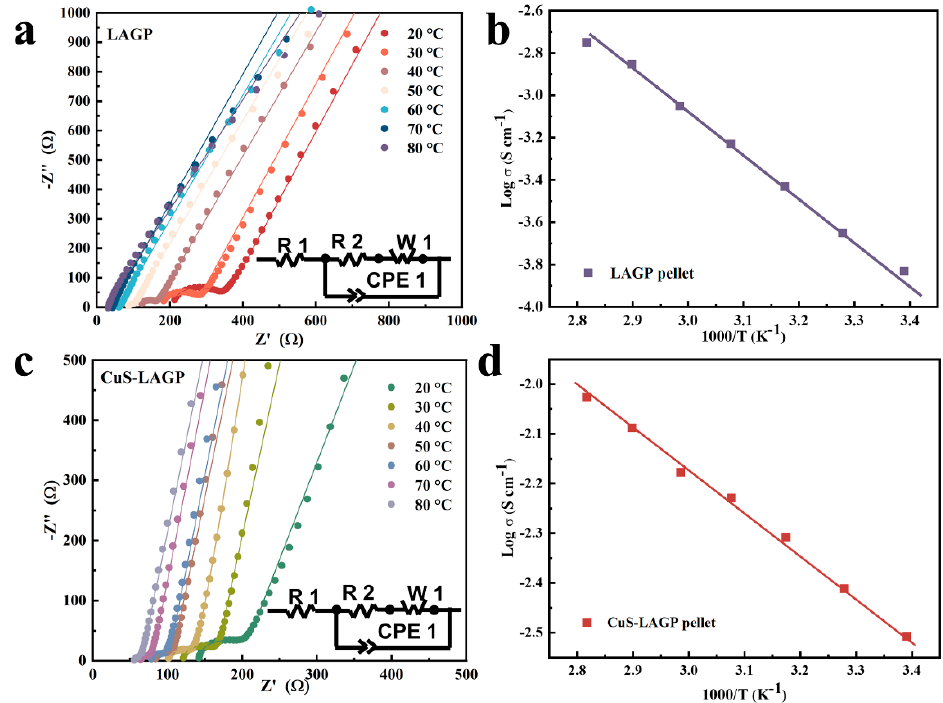
Figure 4. ( a ) Nyquist plot of an LAGP pellet from 20 to 80 °C and ( b ) its corresponding Arrhenius plot. ( c ) Nyquist plot of a CuS-LAGP pellet from 20 to 80 °C and ( d ) its corresponding Arrhenius plot.